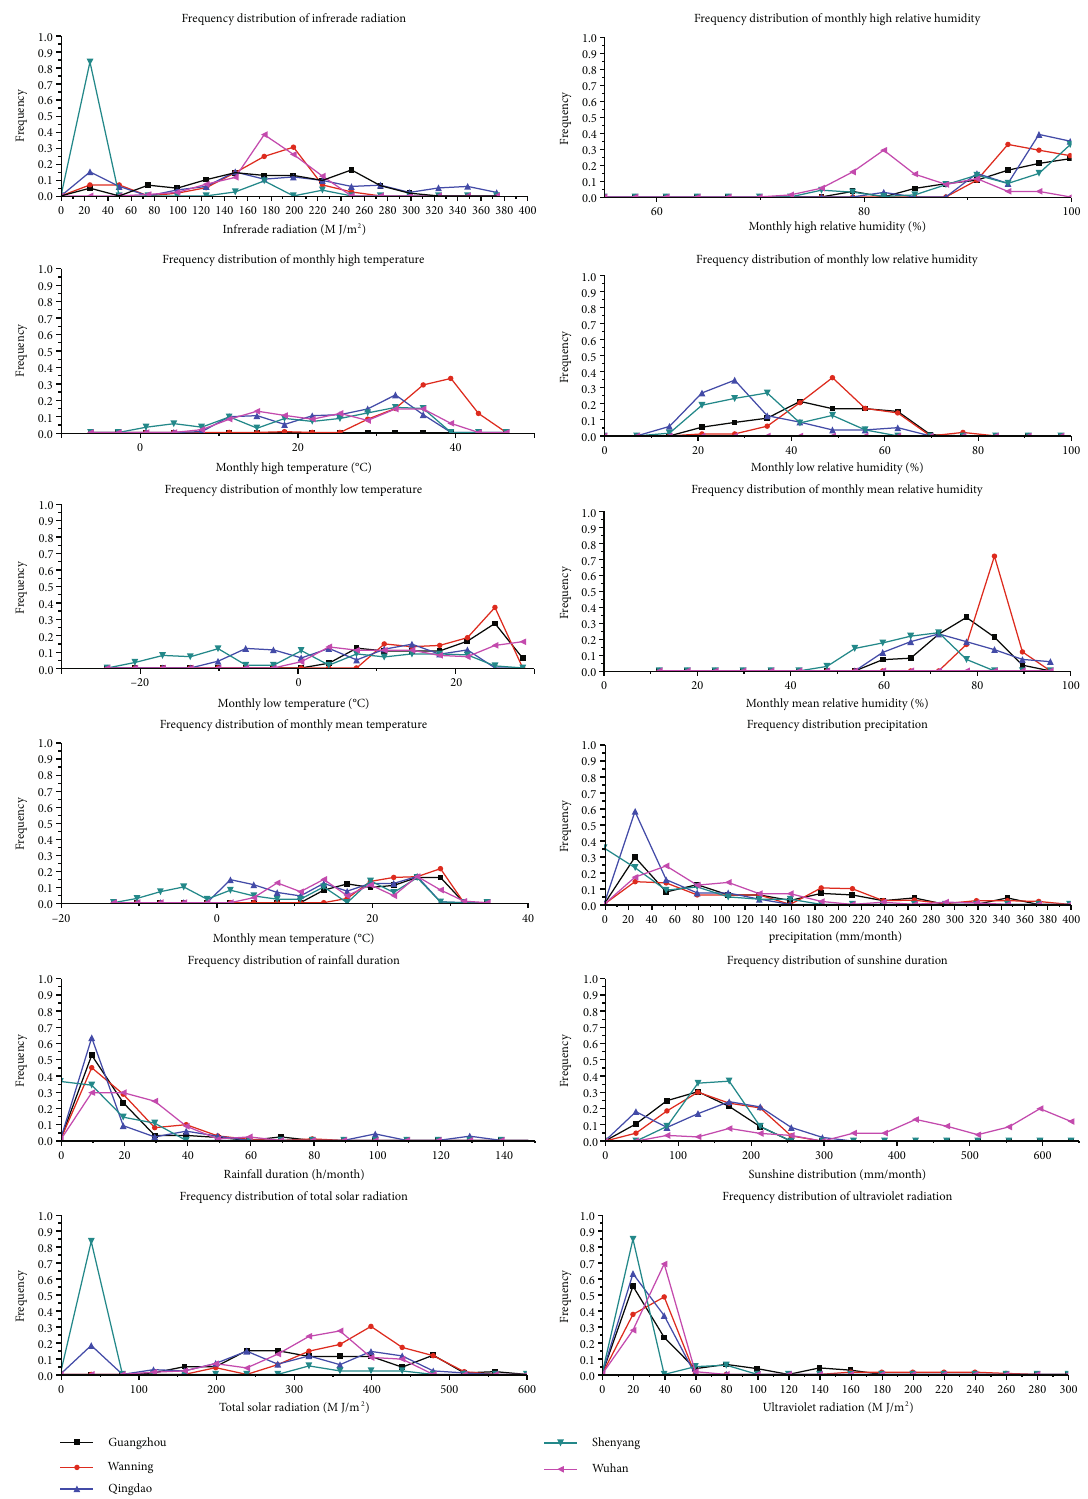
Figure 3: Frequency distribution graphs of climatic